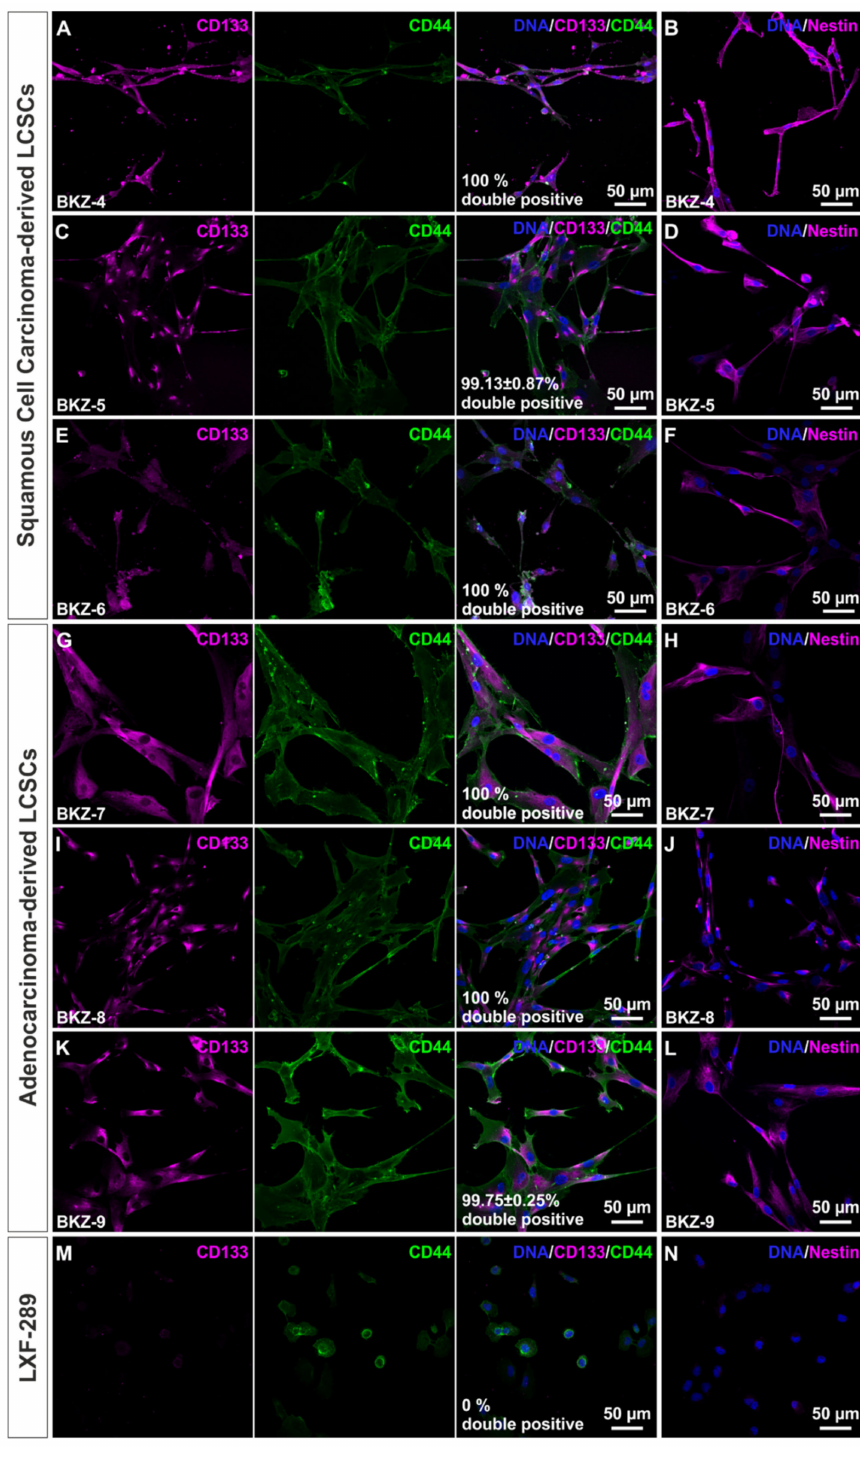
Figure 2. Isolated squamous cell carcinoma-derived and adenocarcinoma-derived lung cancer stem cell-like cells express higher amounts of cancer stem cell markers CD133, CD44, and Nestin in comparison to lung adenocarcinoma-derived cell line LXF-289. Immunocytochemistry revealed the presence of cancer stem cell markers CD133 and CD44 as well as the stem cell marker Nestin on protein level in ( A – F ) BKZ-4, BKZ-5, and BKZ-6 as well as ( G – L ) BKZ-7, BKZ-8, and BKZ-9. ( M , N ) Well-established lung adenocarcinoma-derived cell line LXF-289 did not express CD133 and Nestin and only express CD44 in low amounts in comparison to BKZ